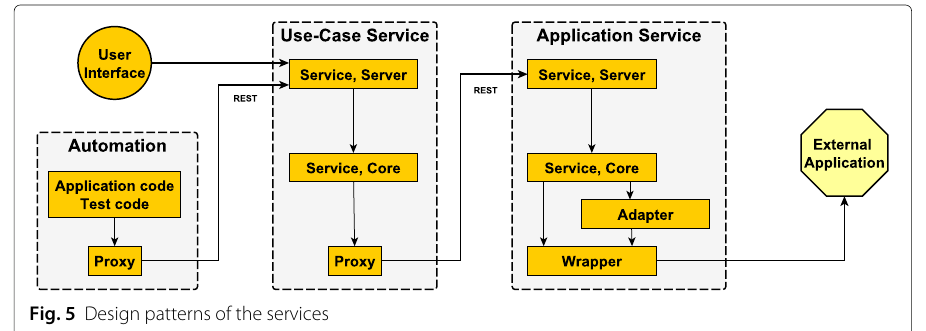
Fig. 5 Design patterns of the services